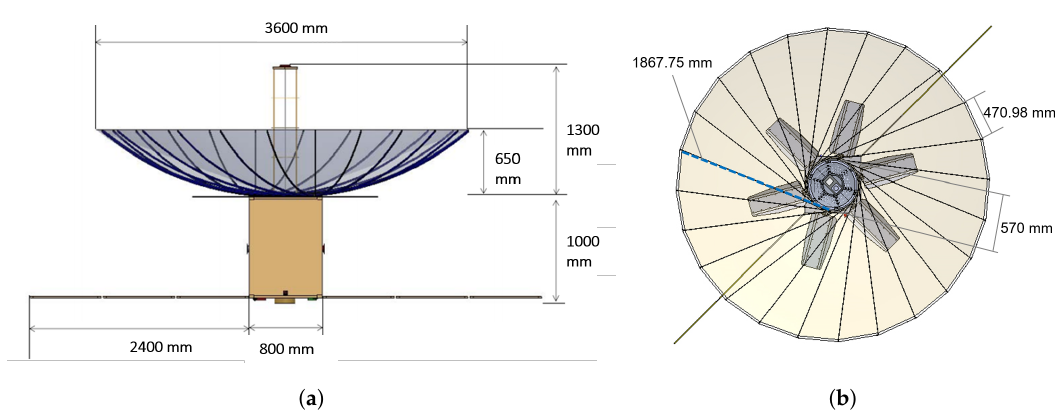
Figure 3. Deployable parabolic reflector in ( a ) profile and ( b ) top view.